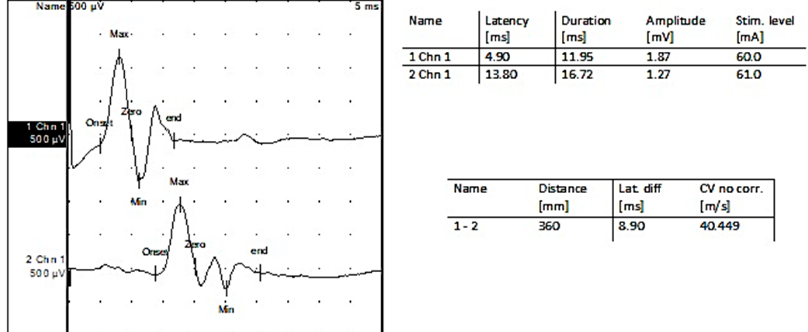
Figure 3. Motor nerveconduction: Left deepperonealnerve .